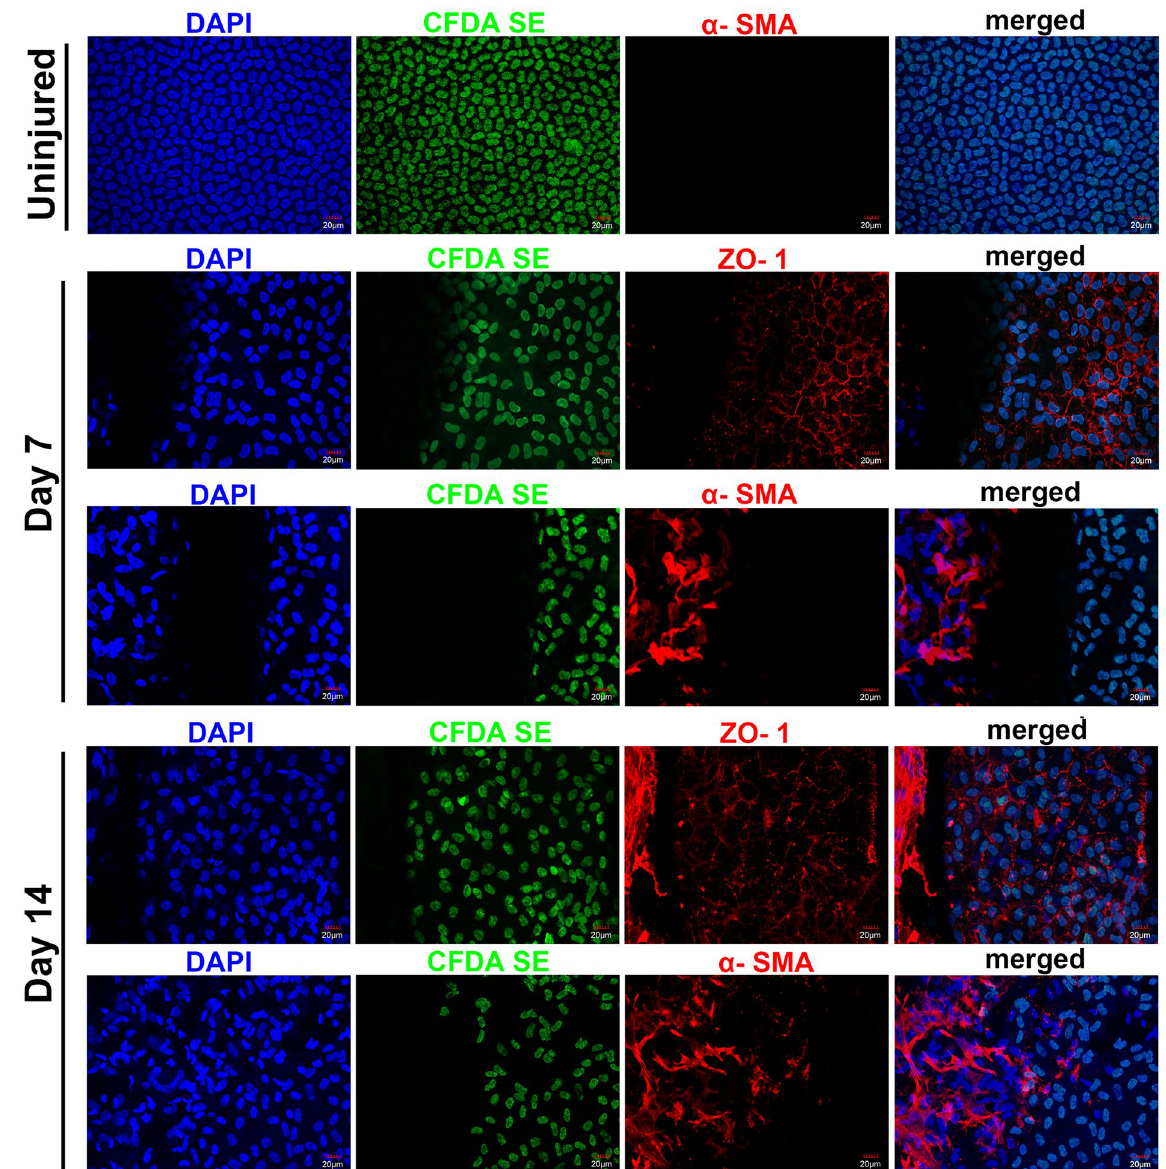
Figure 8. Whole-mount staining of ZO-1 and α -SMA on a DM stripping cornea. ZO-1 expression in the endothelial cells close to the wound border decreased on day 7, cells on the stromal surface of the wound area were not labeled with CFDA SE but were highly expressed with α -SMA. On day 14, ZO-1 expression was regained in the endothelial cells close to the wound border. CFDA SE negative cells close to the wound border also showed positive ZO-1 expression. α -SMA was maintained in the CFDA SE negative cells, while it was negative in the CFDA SE-labeled cells. Bars represent 20 μ